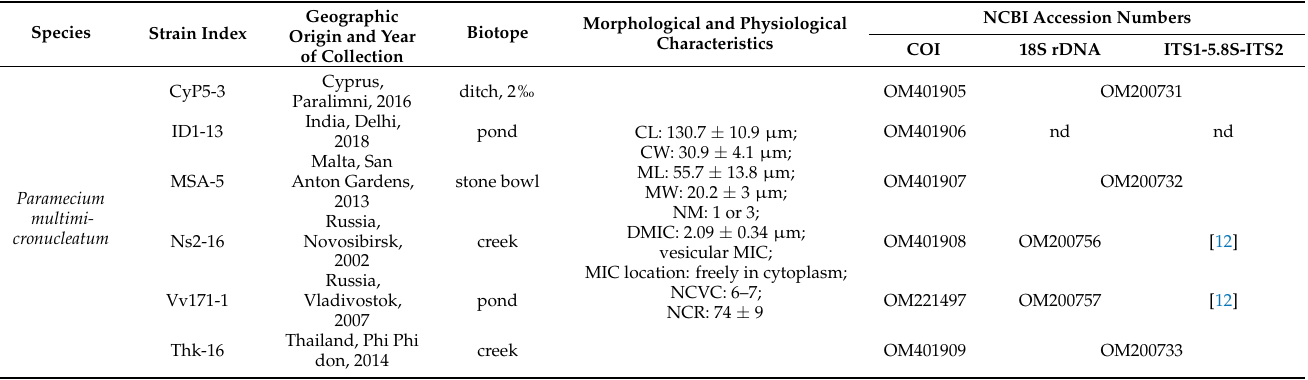
Table 1. Data on the strains used in the